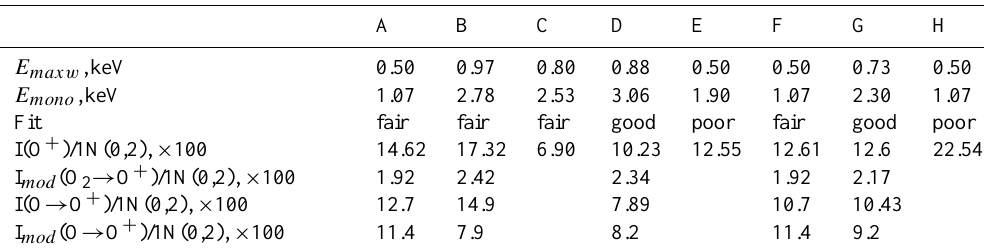
1N(0,2) intensity, modeled brightness from the 2